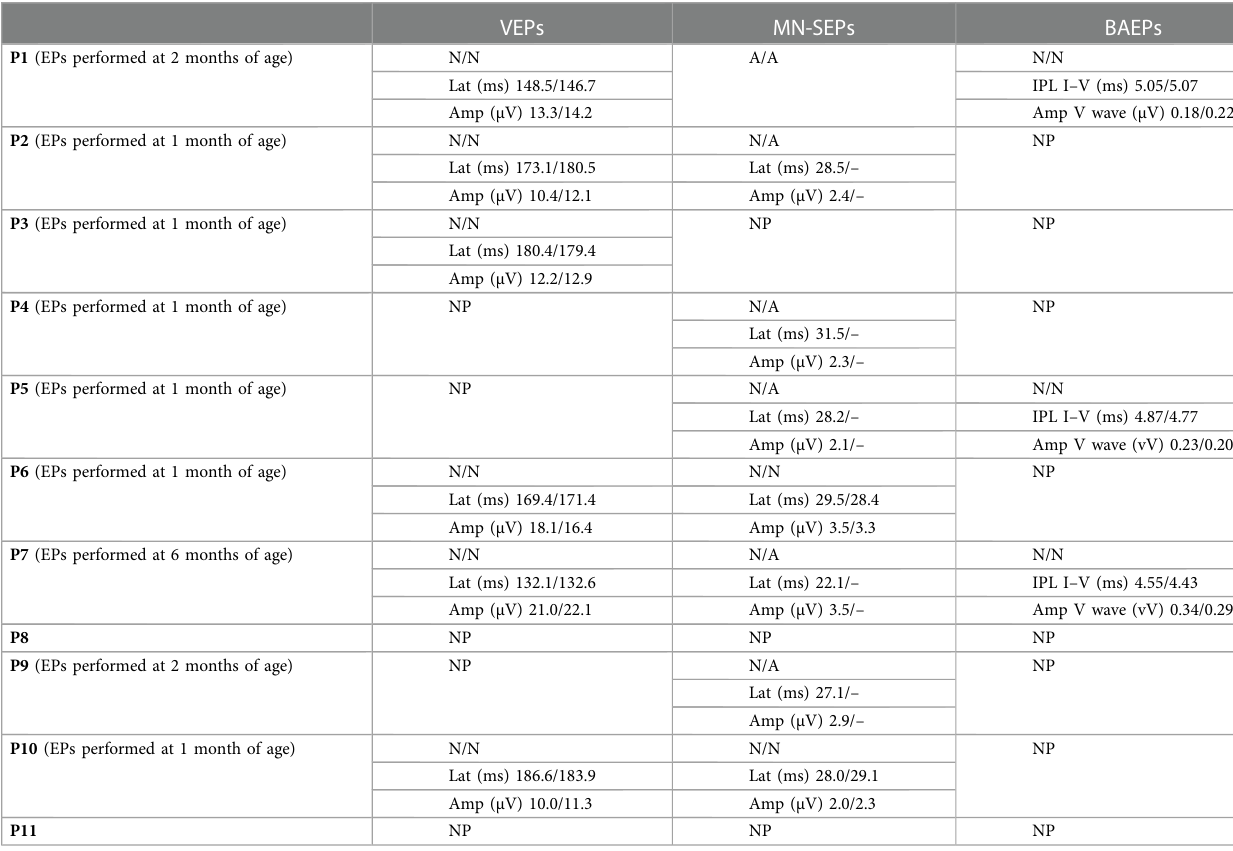
TABLE 3 Details of neurophysiological features.